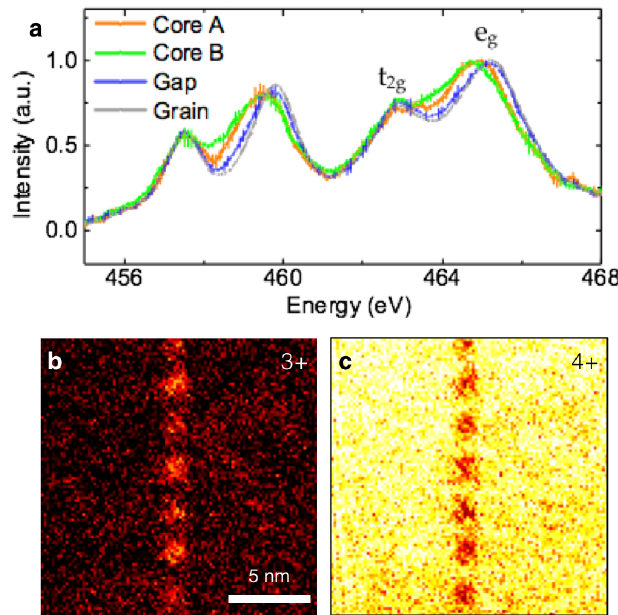
Figure 24. ( a ) EELS spectra obtained from the core-A, core-B, gap between cores along the boundary and the bulk. ( b , c ) show the fitted maps of Ti 3+ and Ti 4+ along the 10° grain boundary in a SrTiO 3 bi-crystal, respectively. The valence mapping of Ti obtained by multiple linear least squares fitting.